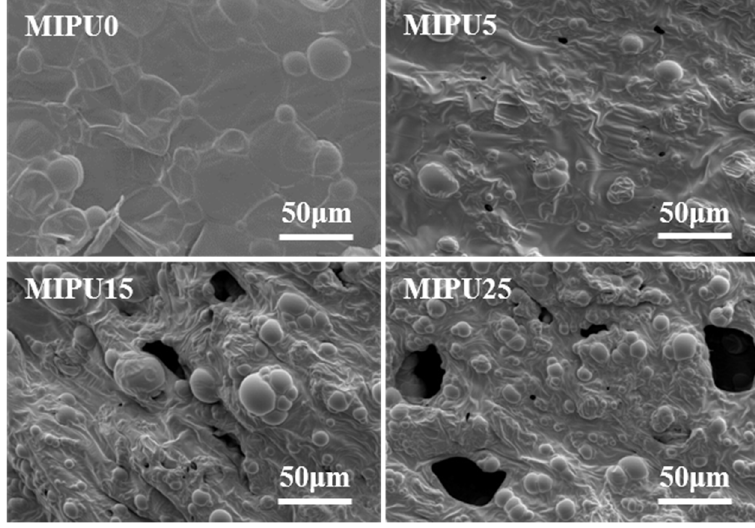
Figure 8. SEM images of the surfaces of the expanded char.